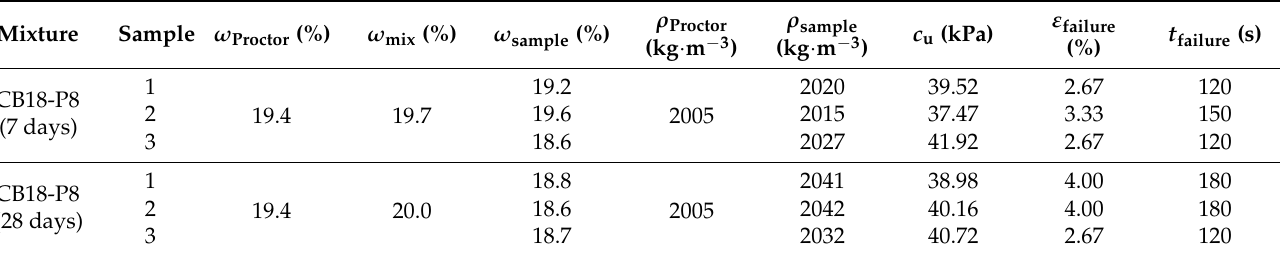
Table 7. Summary of the Simple Compression Tests (Phase II). The subscript ‘r’ stands for ‘repeated’ and NA for ‘Not